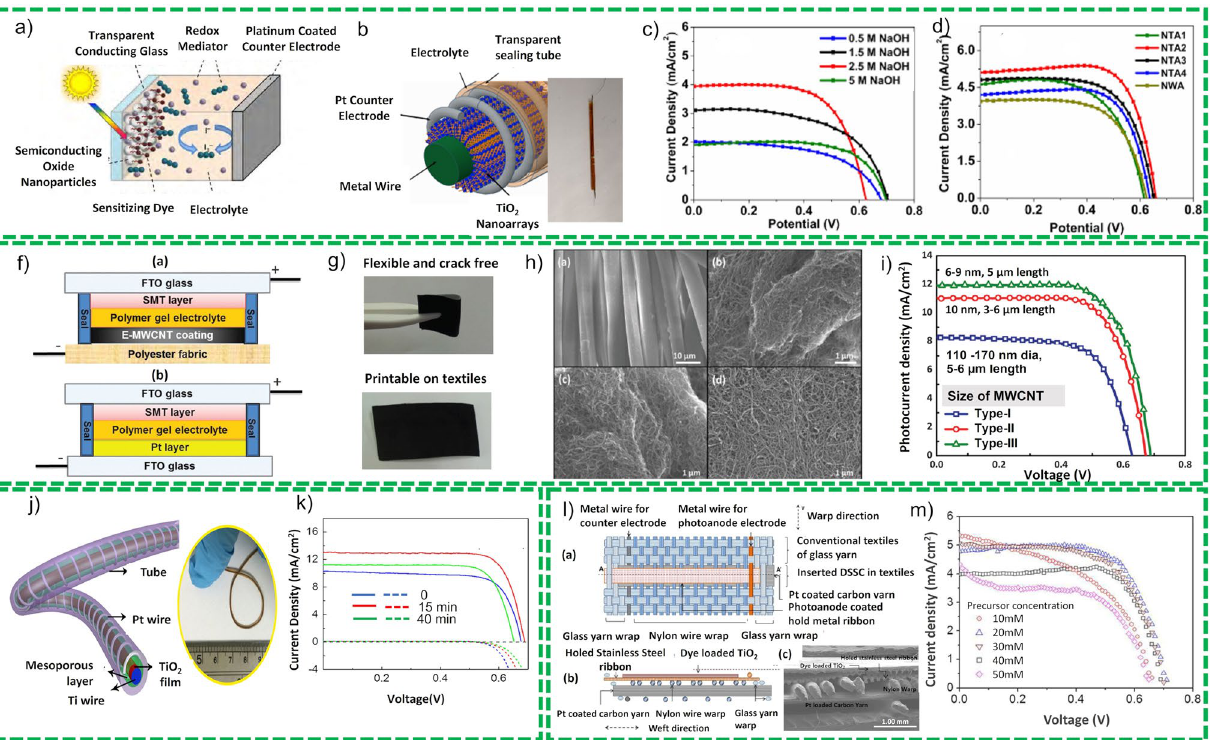
Fig. 5 a Construction and working principle of DSSC, b graphic representation of device and pictorial demonstration of fabricated device, growth mechanism of the novel hierarchical photoanode and performance optimization, c – e optimization of base concentrations, optimization of H 2 SO 4 for the NTA, comparison of nano-tree TiO 2 and Ag deposited nano-tree TiO 2 . Reprinted with permission from Ref. [60]. f Flowchart demonstration of synthesis of E-MWCNT conducting paste and fabrication of an E-MWCNT fabric electrode, g diagram of assembly proposed DSSC and conventional DSSC, and Essential features of an E-MWCNT coated polyester fabric electrode, h FESEM images of polyester fab- ric with hydrophobic surface finish, Laccase suspended E-MWCNT and Gox suspended E-MWCNT, i electrical resistance of the E-MWCNT- coated fabric with the bending cycle, scotch Tape test performed on E-MWCNT coated fabric, clear surface of Scotch Tape and bending stabil- ity. Reprinted with permission from Ref. [61]. j Schematic illustration of DSSC fabrication with GCF counter electrode, k efficiency and PEC comparison with different thickness and bending radius counter electrodes. Reprinted with permission from Ref. [62]. l Schematic representation of the structure of the inserted dye-sensitized solar cells (DSSCs) in the textile in planar view and cross-sectional view of the AA ′ section shown in ( a ) SEM images of the AA ′ section in ( a ), showing the cross-sectional view of the inserted DSSC in the textile, m J–V features for thickness of layers and concentrations of precursors. Reprinted with permission from Ref.